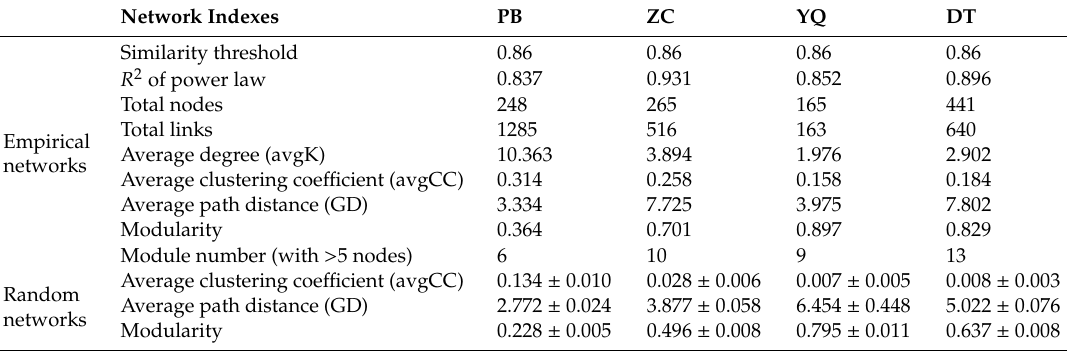
Table 2. Topological properties of the empirical molecular ecological networks of microbial communities and their random networks in di ff erent mining